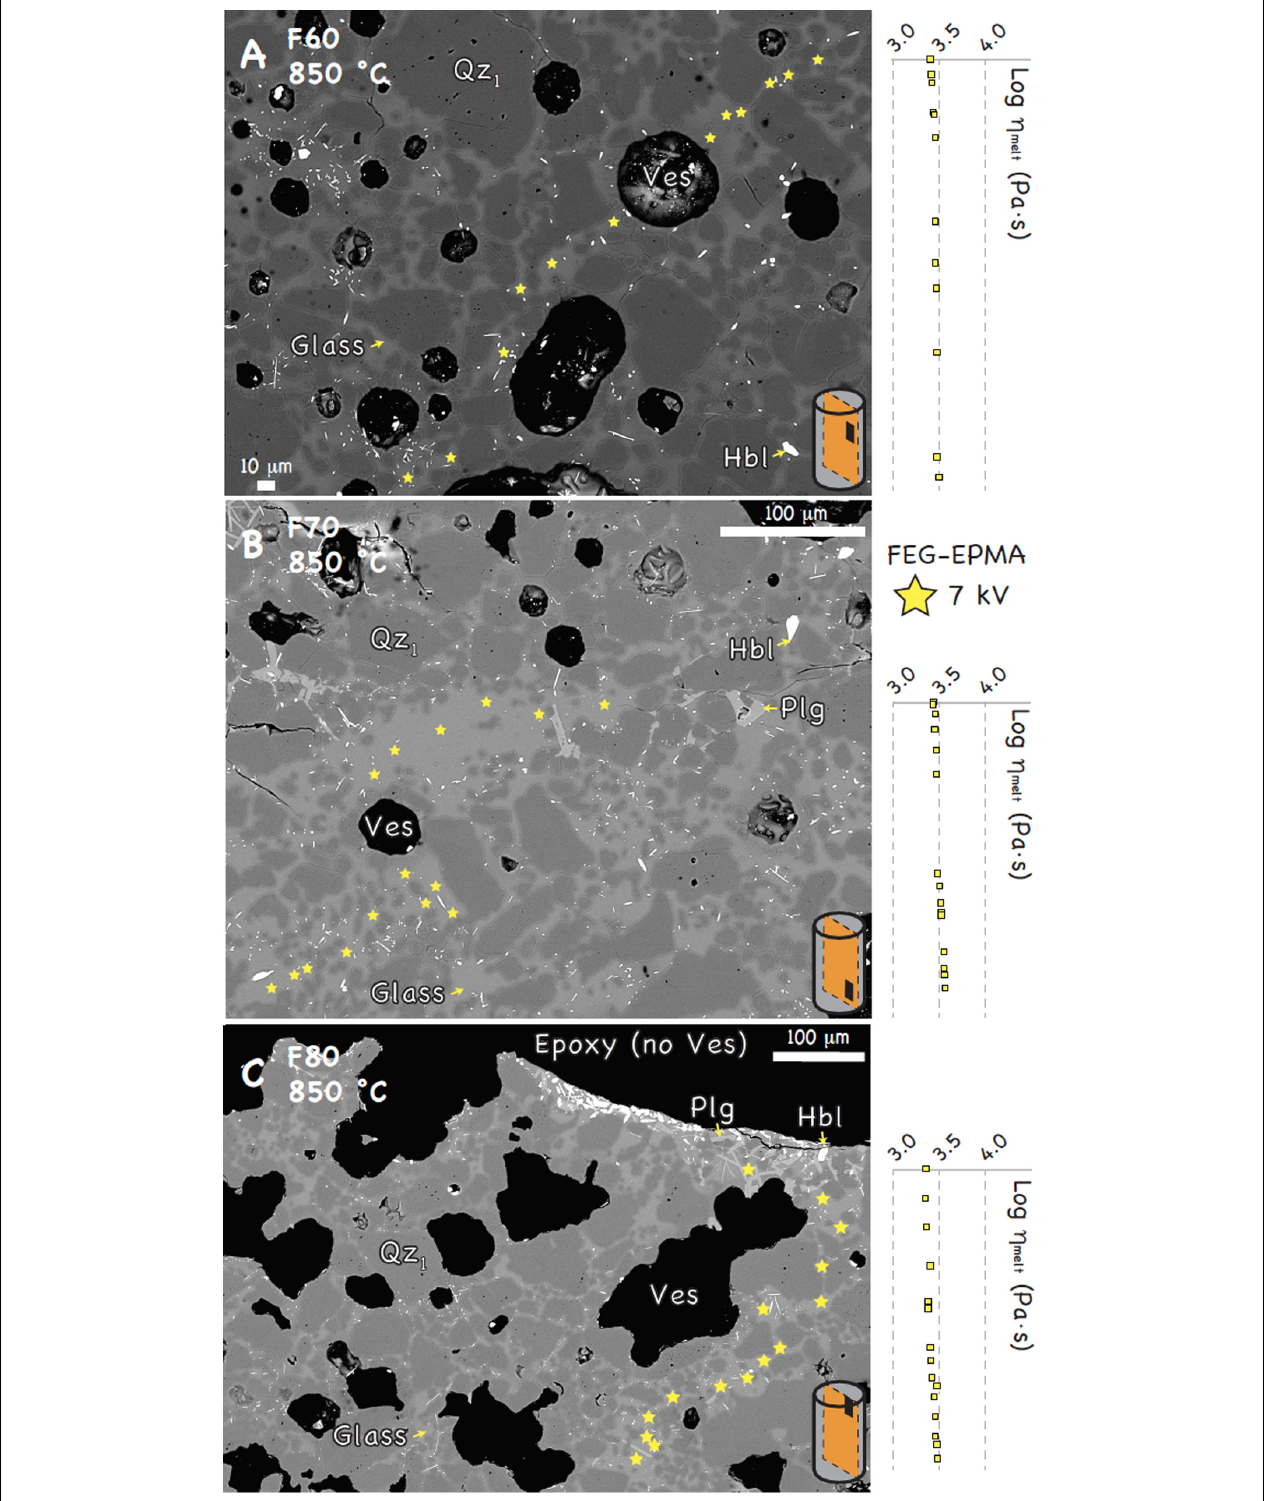
FIGURE 5 | FEG-probe-based BSE images of selected portions within the central polished sections of: (A) F60, (B) F70, and (C) F80 at 850 ◦ C. Error bars corresponding to 2 σ are smaller than symbols. Acronyms are for: Qz 1 = pre-existing quartz (dark gray); Plg = plagioclase (light gray); Hbl = hornblende (white elongated phase); Ves = vesicle (black objects, sometimes filled with whitish material that produces electron charging); Glass = residual glass (least dark gray phase). Sketches of cylindrical samples (light gray) show the location of the sample portion (black rectangles) inspected in the sample central section (orange plane).